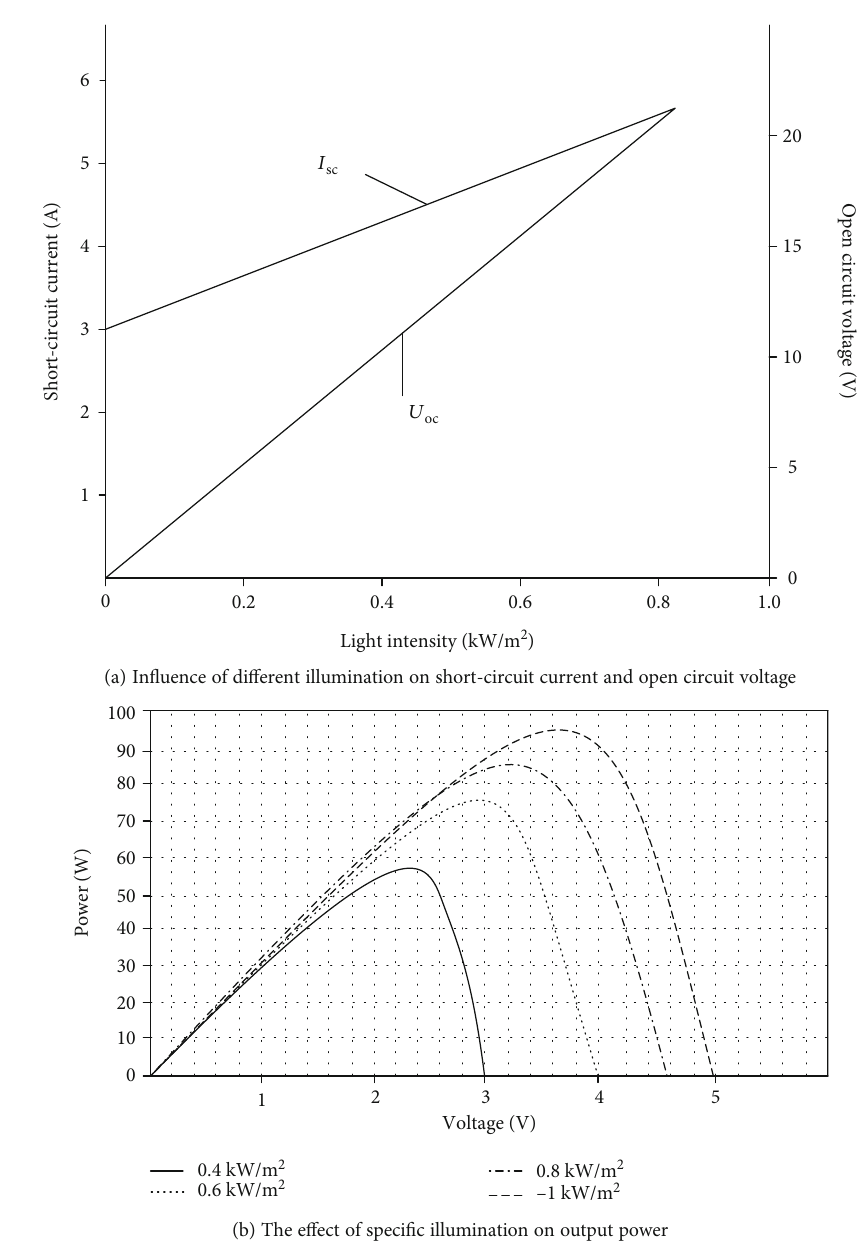
Figure 5: E ff ect of light intensity change on output characteristics of maximum utilization of electric energy of photovoltaic